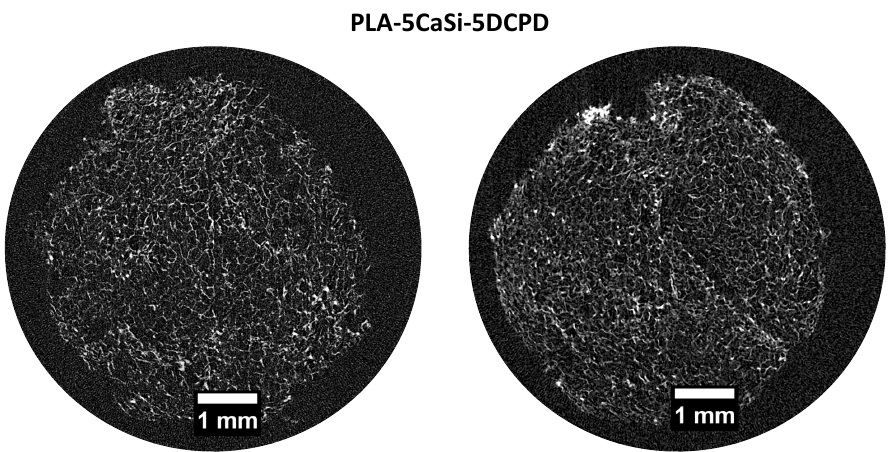
Figure 4. Micro-CT scan of 2 random slices of PLA-5CaSi-5DCPD reveals a highly porous regular “honey-comb” like structure, similar to the other mineral doped scaffolds. Some pores are occluded by radiopaque granules.